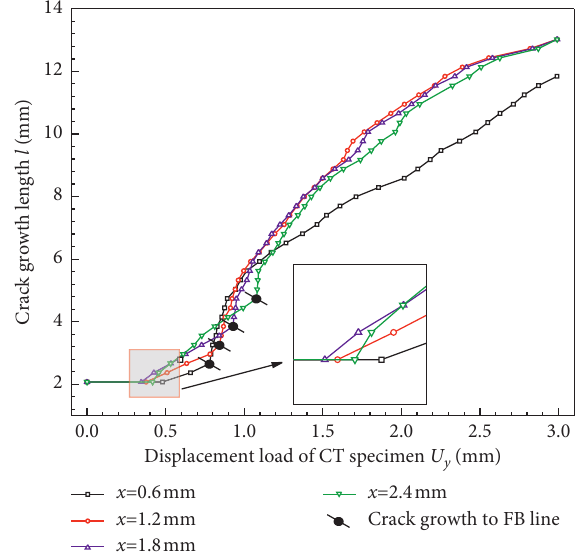
Figure 10: The crack propagation length curves with the dis- placement